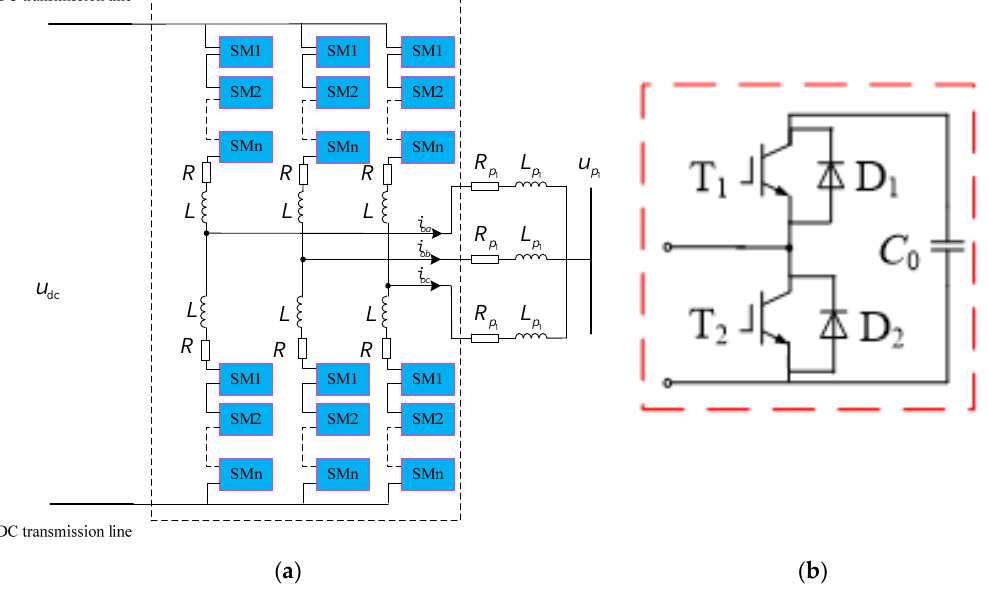
Figure 2. Circuit diagram of MMC: ( a ) Circuit diagram of the inverter side of a three ‐ phase MMC; ( b ) Circuit diagram of Sub ‐ Module (SM).